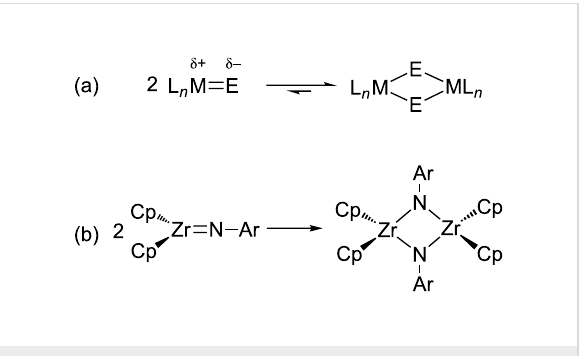
Steric effects nevertheless play an important role, as one can envision a bimolecular pathway to acid–base adduct formation (Figure 2a). Such dimerization does occur in cases with insuffi- cient steric encumbrance (e.g., the bis- μ -imido zirconium complexes of Bergman, Figure 2b) [25]. Thus, as for the main- group FLPs of Stephan and others, moderately-to-severely bulky ligands must be employed to favor the most reactive monomeric M ═ E FLPs.